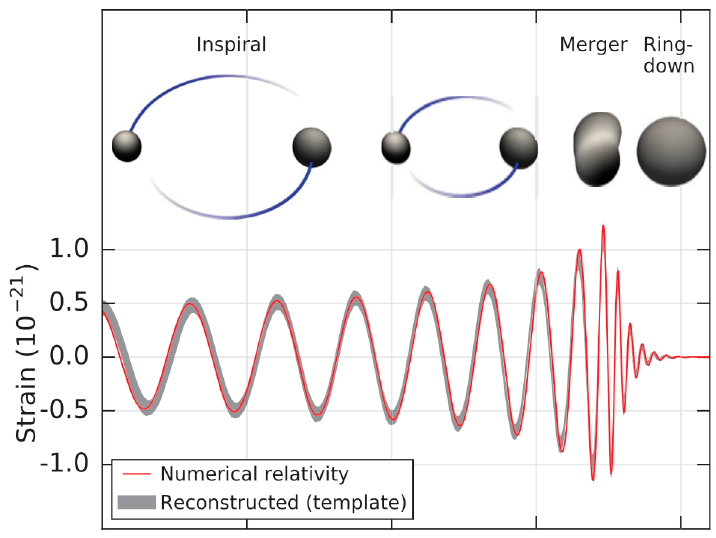
Figure 12. Showing the phases: binary orbits inspiraling, black holes merging, and final black hole ringing down to spherical or ellipsoidal shape [2].